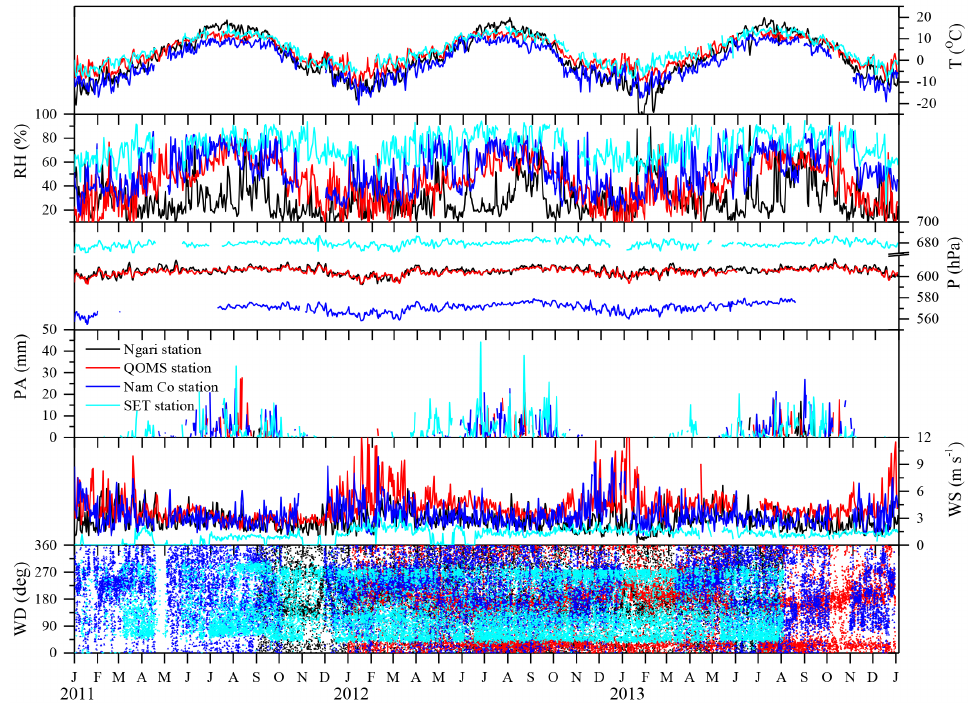
Figure 2. Time series for hourly air temperature ( T ), relative humidity (RH), pressure ( P ), precipitation amount (PA), wind speed (WS) and wind direction (WD) in the HTP during 2011–2013 at the Ngari station (black), the QOMS station (red), the Nam Co station (blue) and the SET station (cyan),